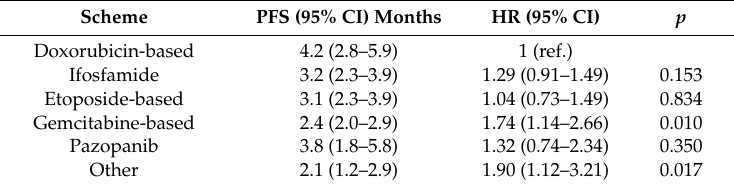
Table A3. Progression-free survival (PFS) on di ff erent systemic therapy regiment irrespective of the line of treatment. HR, hazard